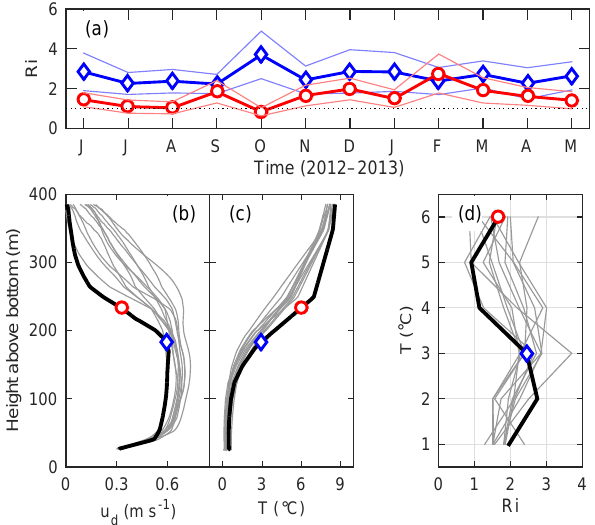
Figure 13. Monthly Richardson number, Ri , calculations at moor- ing C2 in the channel. (a) Monthly averages of hourly 10m Ri cal- culated at depths centered at the 3 ◦ C (blue, diamonds) and 6 ◦ C (red, circles) isotherms. Envelopes are the standard error assuming every 13th hourly sample is independent. Dashed line is Ri = 1. Pro- files of (b) downstream velocity component and (c) temperature av- eraged in each month. The profile from May is highlighted by the bold line together with the depth of the 3 and 6 ◦ C isotherms by the corresponding markers. (d) Monthly 10m Ri for unit increments of T . The May profile is